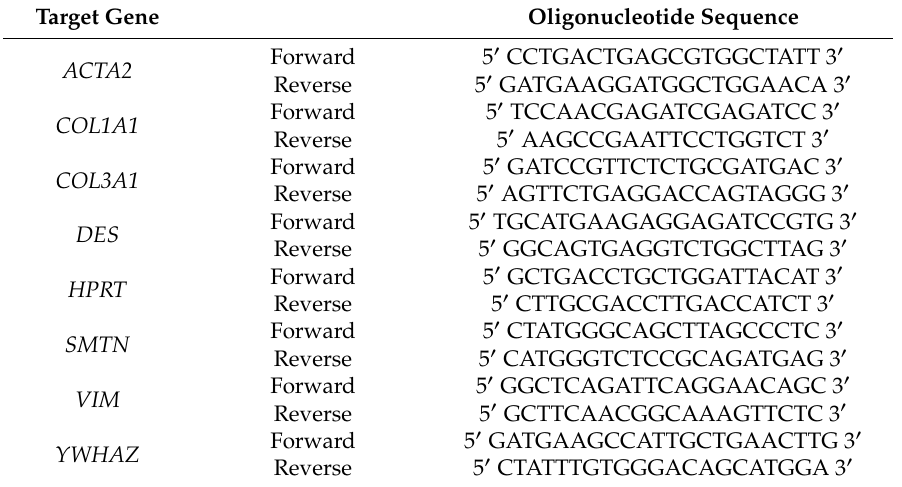
Table 2. Primer sequences used for real time-polymerase chain reaction